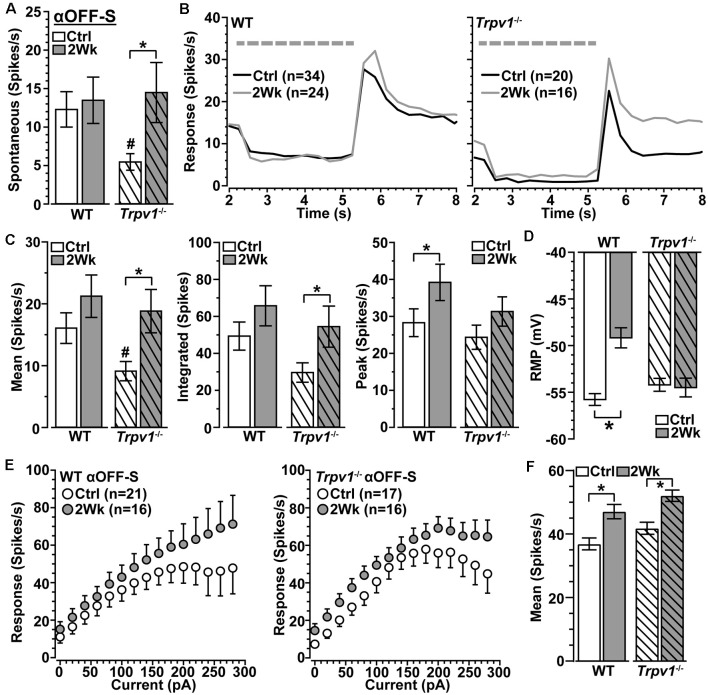
Elevated IOP similarly influences WT and Trpv1−/− αOFF-S RGCs. (A) Spontaneous spike activity of Trpv1−/− αOFF-S RGCs is significantly less than WT for control cells (#p = 0.025) but increased with elevated IOP (*p = 0.022). (B,C) Response to light offset increases for both WT and Trpv1−/− αOFF-S RGCs, including peak response for WT (#p = 0.05) and mean and integrated response for Trpv1−/− (*p ≤ 0.05); the mean response for Trpv1−/− control cells was less than WT (#, see Figure 4). (D) Elevated IOP depolarized RMP for WT (*p ≤ 0.001) but not Trpv1−/− αOFF-S cells (p = 0.81). (E) The voltage response of WT and Trpv1−/− αOFF-S RGCs following brief (1 s) pulses of depolarizing current (0–280 pA; 2 s inter-stimulus interval). (F) Elevated IOP significantly increased response averaged across current pulses for both genotypes compared to respective control cells (*p ≤ 0.002), which did not differ by genotype (p = 0.21). Statistics: Student’s t-tests (A,D), Student’s t-tests (peak response) or Mann–Whitney tests (mean and integrated responses, C), Kruskal–Wallis, Dunn’s post hoc
(F). Data presented as mean ± SEM.